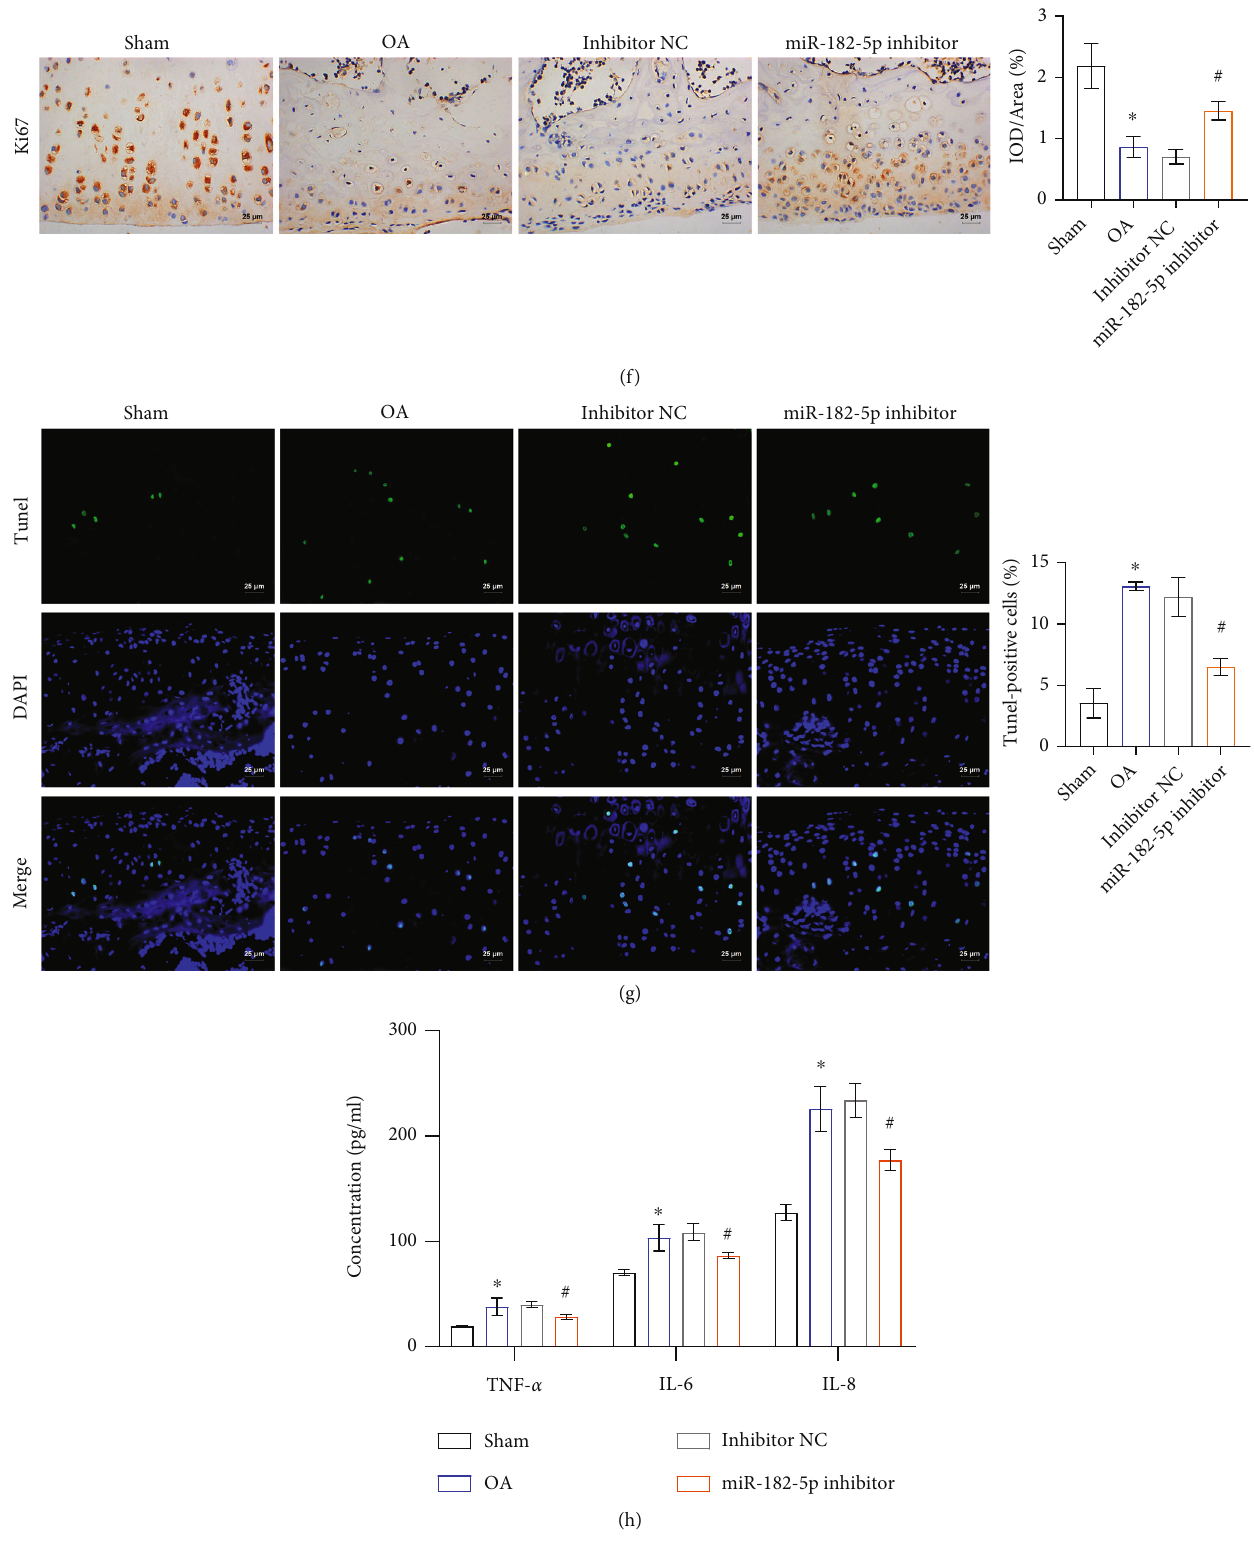
Figure 6: Inhibition of miR-182-5p alleviated the process of OA in rats. RT-qPCR was conducted to validate the gene expression of (a) miR- 182-5p and (b) FGF9. (c) The protein expression of FGF9. (d) HE showed the structure of cartilage tissues. (e) Proteoglycans in cartilage tissue were exposed by S – O staining. (f) IHC was adopted to capture the expression of Ki67. (g) The rate of apoptosis was measured by TUNEL. (h) The expression of in fl ammatory factors (TNF- α , IL-6, and IL-8) was evaluated by ELISA. Magni fi cation=400. Scale bar =25 μ m. * P < 0 : 05 vs. Sham. # P < 0 : 05 vs. inhibitor